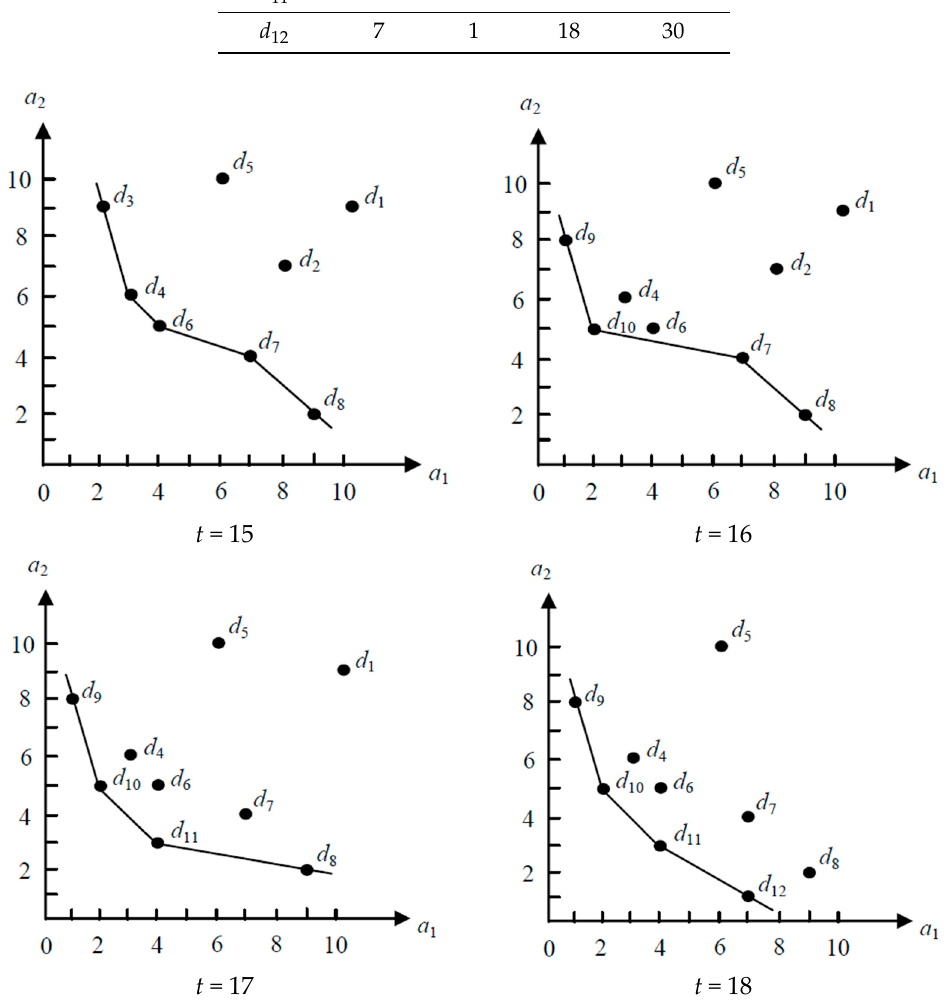
Figure 1. The example of a continuous skyline query being shown in transition from times 15 to 18. Table 1. The set of data objects with arrival and expiration times.